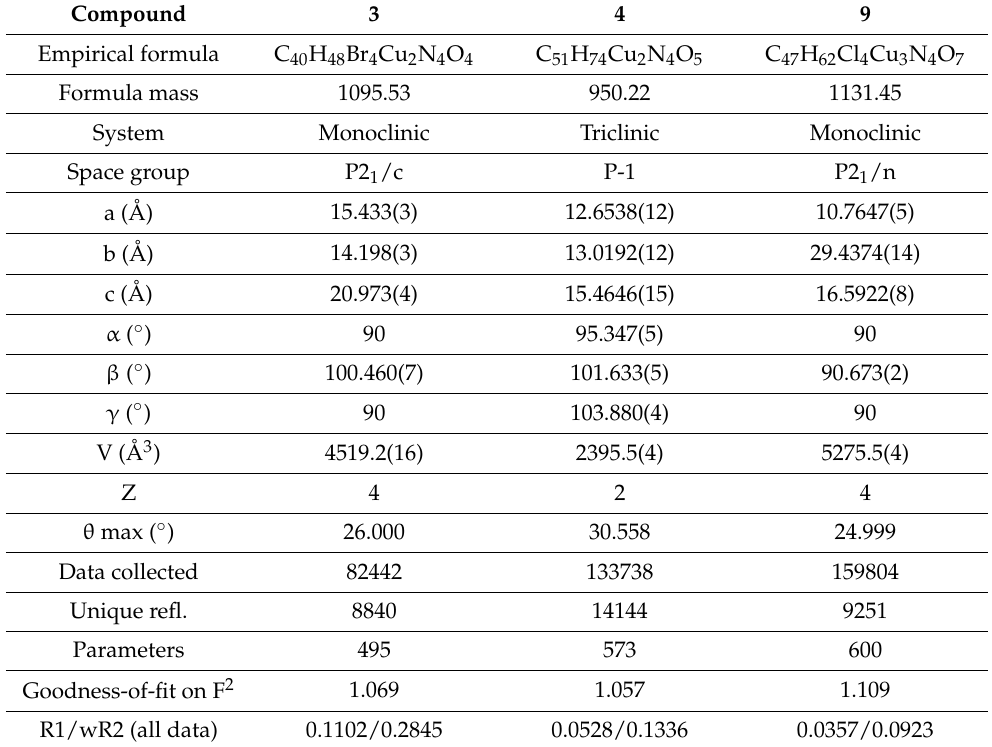
Table 3. Crystallographic data and processing parameters of 3 , 4 , and 9